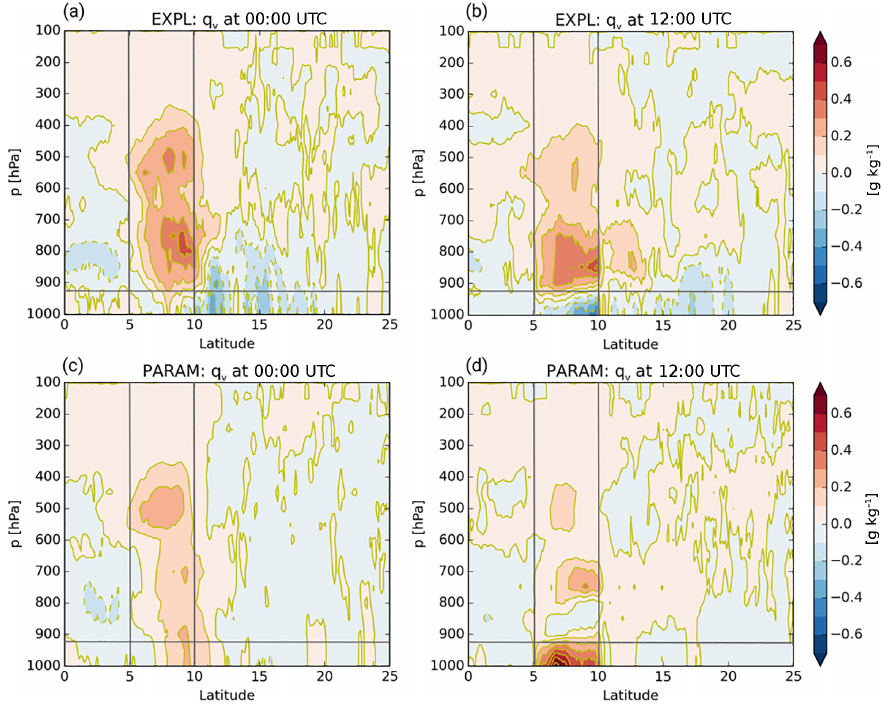
Figure 12. South–north distribution of 8 ◦ W–8 ◦ E averaged q v differences of ICON EXPL (a, b) and PARAM (c, d) f op = 0 . 1 minus f op = 1 . 0 for July 2006. Panels (a) and (c) show 00:00UTC and panels (b) and (d) show 12:00UTC. Grey lines indicate the borders of the DACCIWA box and the 925hPa level used in Figs. 10 and